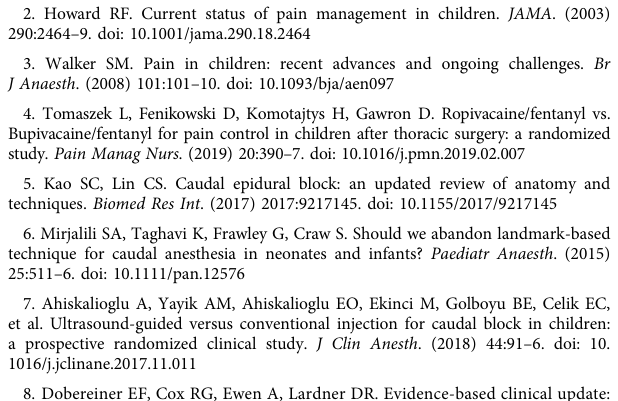
Supplementary Figure 2 Funnel plot of comparison of combined group and control group: A. Pain score at 24h (T5); B. First postoperative analgesic supplementation time; C. Incidence of postoperative adverse